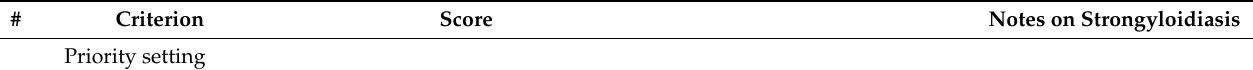
Table 1. Strongyloides stercoralis against 12 criteria for NNDL